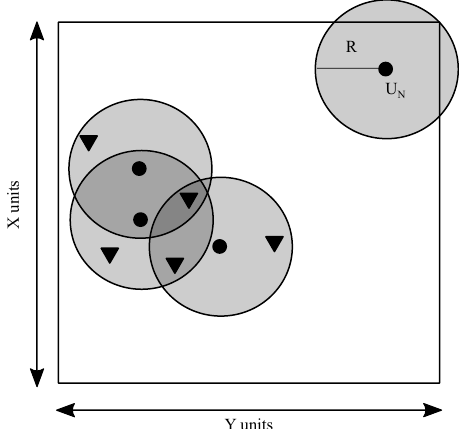
Figure 2. Diverse scenario in wireless sensor networks (WSNs)